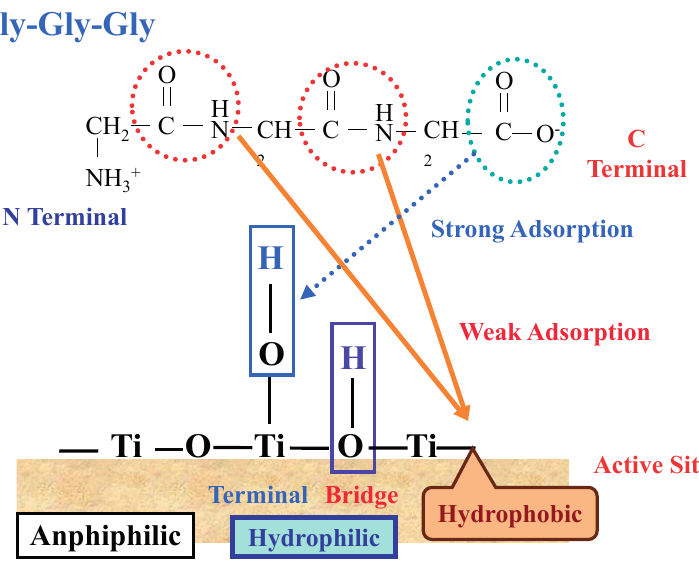
Figure 13. Schematic presentation of the adsorption of the peptide (Gly-Gly-Gly) on the hydrophilic and hydrophobic surface of TiO 2 (ST-01). Reprinted with permission from [43] © 2014 American Chemical